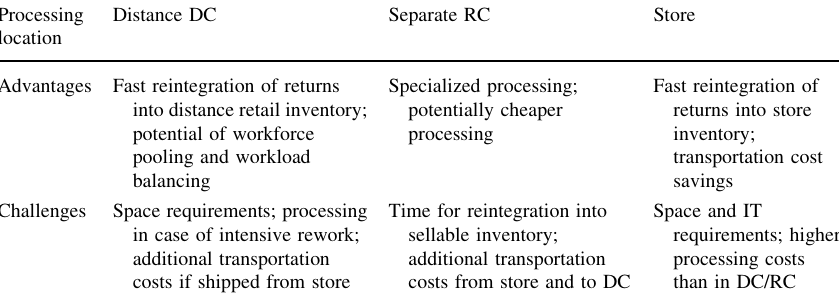
Table 6 Summary of omni-channel return processing locations Processing